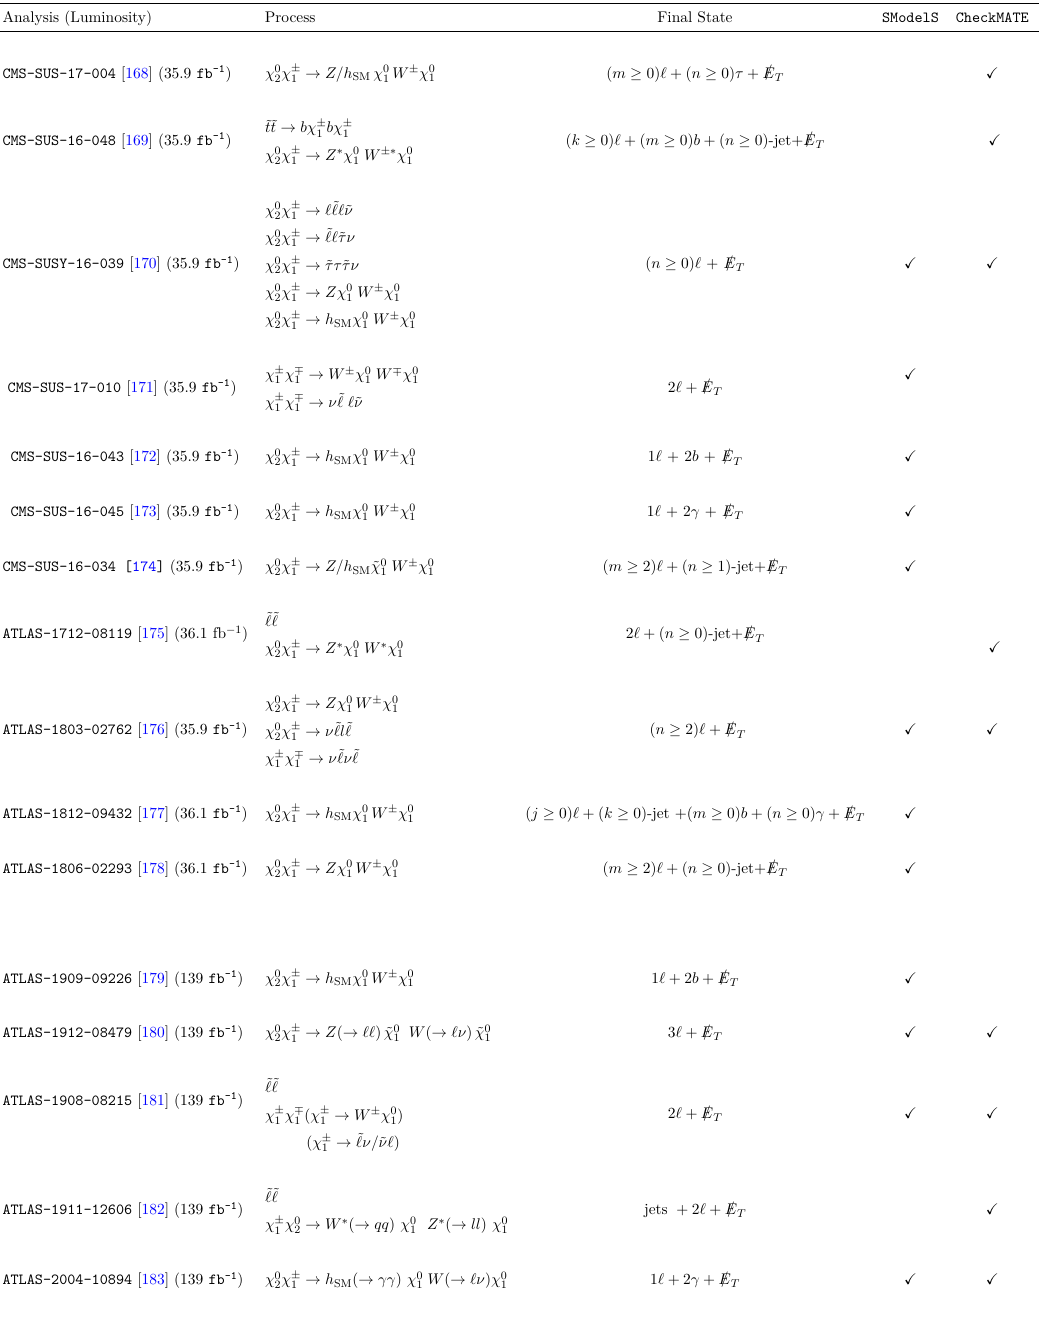
Table 2. Relevant experimental analyses, along with the processes and final states considered, in search for the electroweakinos at the 13 TeV LHC with the data sets at ∼ 36 fb − 1 and 139 fb − 1 hat are implemented in CheckMATE and/or SModelS